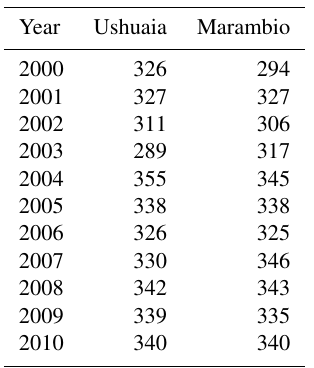
Table 4. Number of measurement days during 2000–2010.